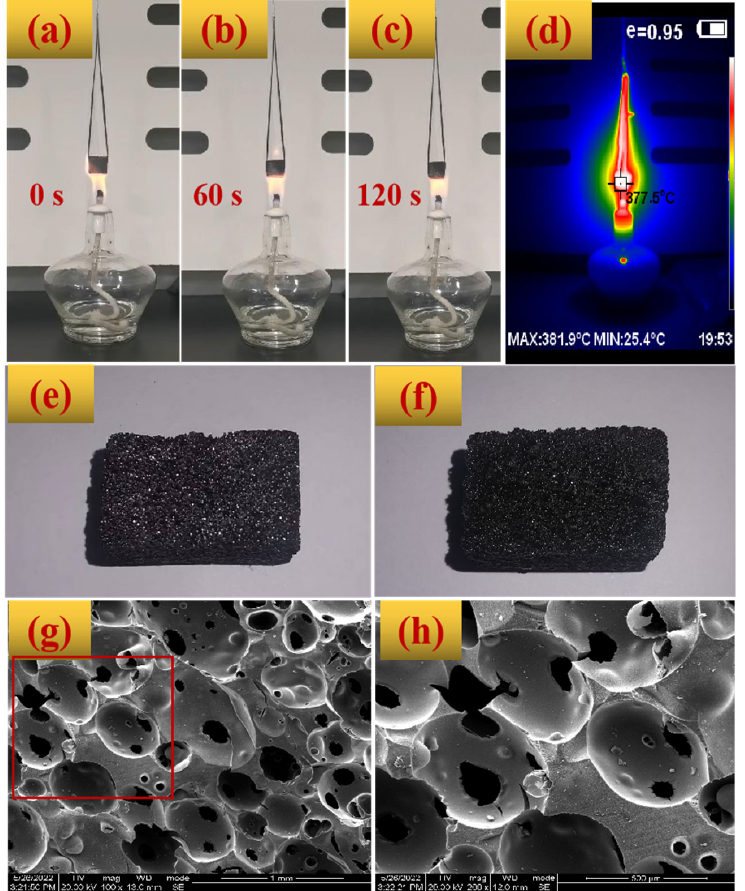
Figure 7. Images of BZPN foams ( a – c ) during flame test at 0 s, 60 s, and 120 s, ( d ) real ‐ time infrared image at 60 s, ( e ) image before, and ( f – h ) after burning test. image at 60 s, ( e ) image before, and ( f – h ) after burning